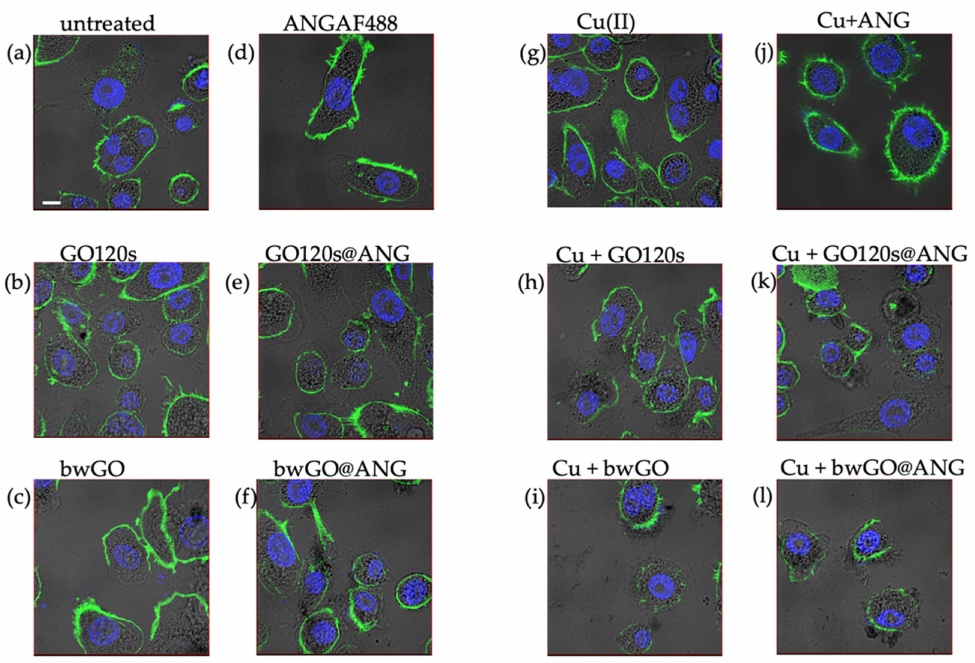
Figure 5. LSM-merged micrographs of optical bright field (in grey) and fluorescence (in blue: nuclear staining, Hoechst, λ ex/em = 405/425–450 nm; in green: cytoskeleton actin, Actin Green, λ ex/em = 488/500–530 nm) of PC-3 cells untreated (( a ): CTRL) and after 24 h of treatment with: 2.78 µ g/mL GO120s ( b ) or bwGO ( c ); 500 nM AngAF488 ( d ); the hybrids (2.78 µ g/mL in GO and 500 nM ANG) of GO120s@ANGF488 ( e ) or bwGO@ANGF488 ( f ); 500 nM CuSO 4 ( g ); 500 nM Cu supplemented medium with 2.78 µ g/mL of GO120s ( h ) or bwGO ( i ); 500 nM Cu supplemented medium with ANGAF488 ( j ) or hybrids (2.78 µ g/mL in GO and 500 nM ANG) of GO120s@ANGF488 ( k ) and bwGO@ANGF488 ( l ). Scale bar = 10 µ